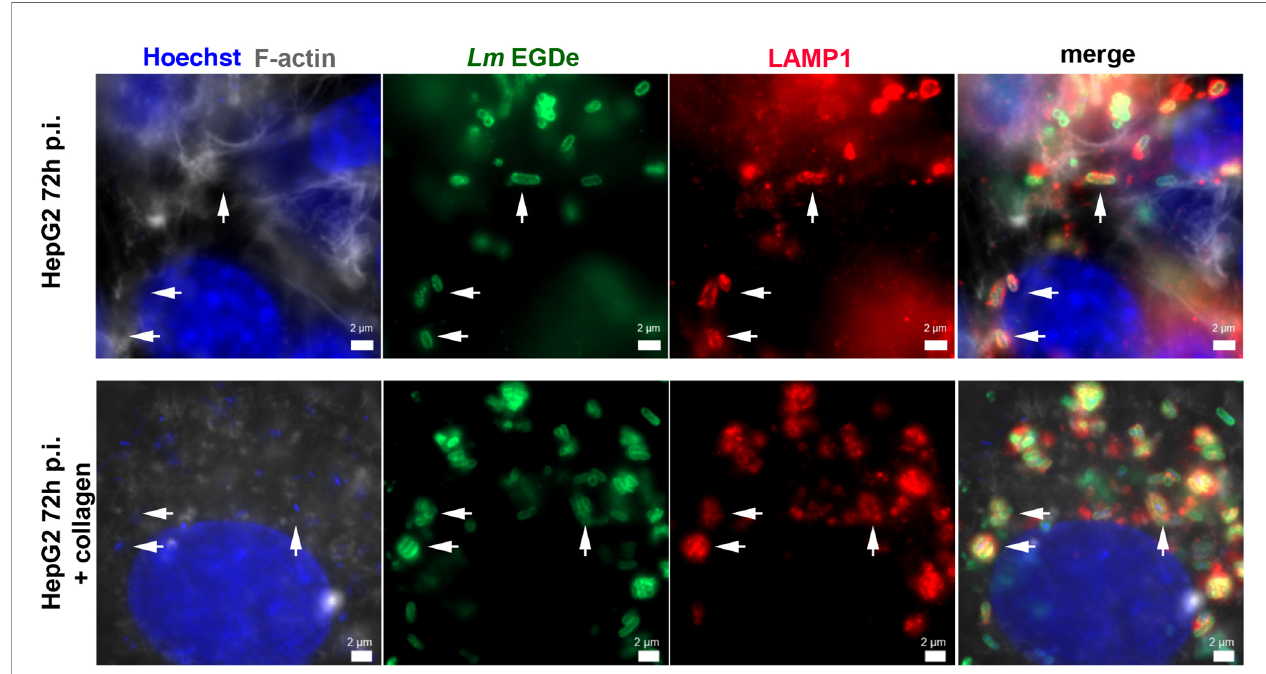
SUPPLEMENTARY FIGURE 1 | (B) Collagen coating increases bacterial spreading during 3-day Listeria infection in HepG2 cells. (B) High magni fi cation micrographs showing cells at 72 h p.i. stained with Hoechst to label nuclei (blue), AF-647-phalloidin to label F-actin (white), Listeria antibody to label bacteria (green) and LAMP1 antibody to label LisCVs (red). Bacteria in LisCVs, which are LAMP1-positive, are observed both in HepG2 grown on uncoated (top) or collagen-coated coverslips (bottom). White arrows indicate representative